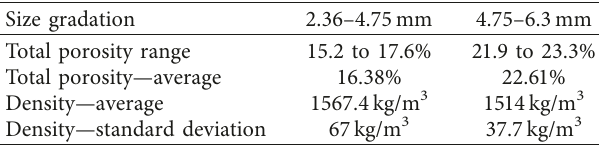
Figure 5: Comparison of compressive strength with literature. Table 6: Porosity and density of the pervious concrete